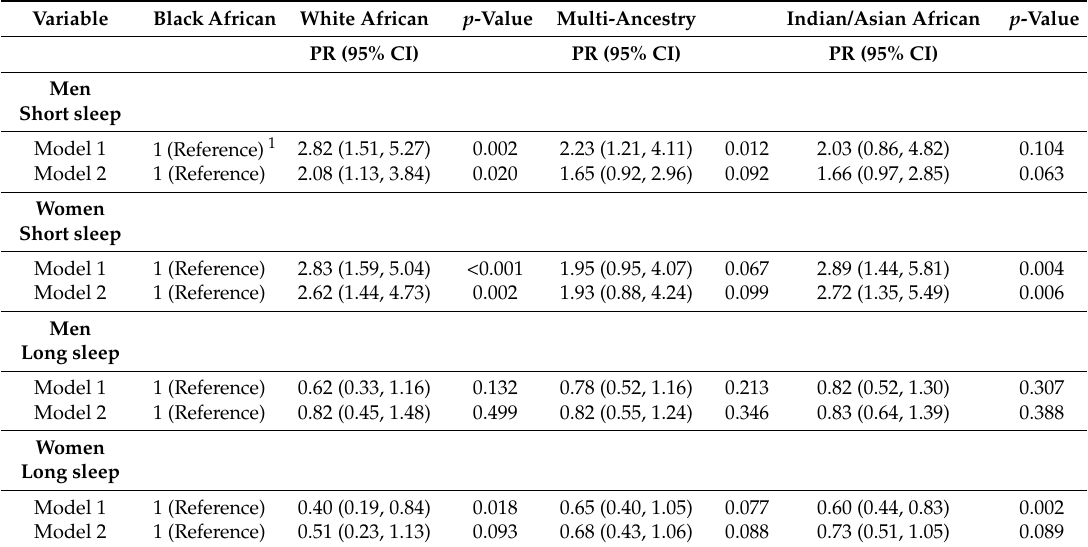
Table 3. Prevalence ratios for short and long sleep among population groups and